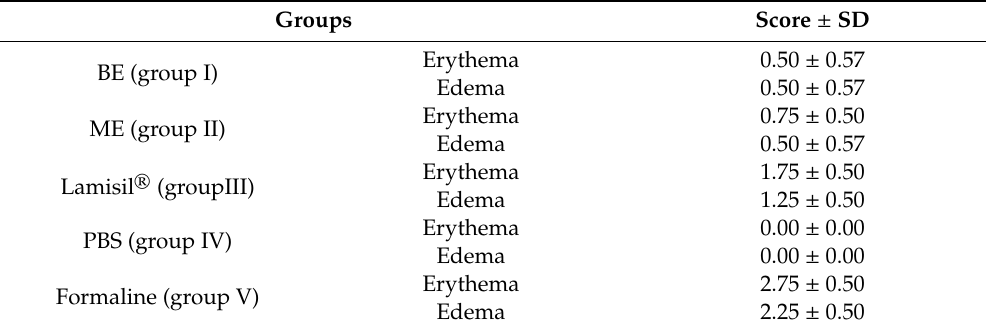
Table 2. Score for skin irritation study on rabbit calculated after 7 days.